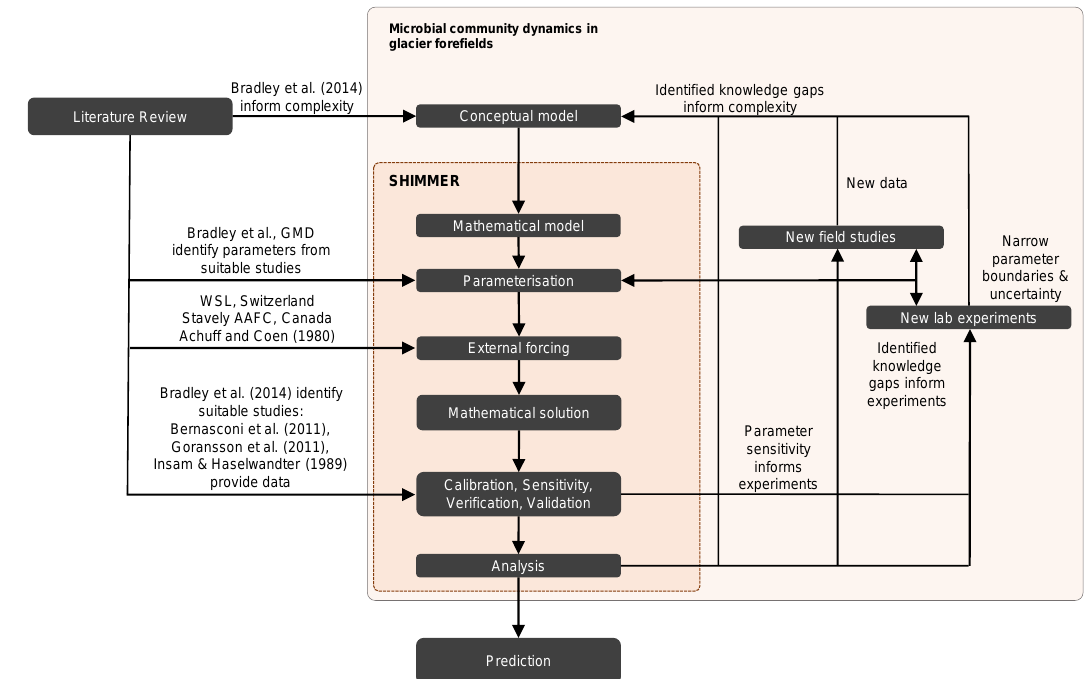
Figure 2. Iterative, fully integrated interdisciplinary framework of SHIMMER, aimed at continuing model development as new data sets emerge and knowledge of the field